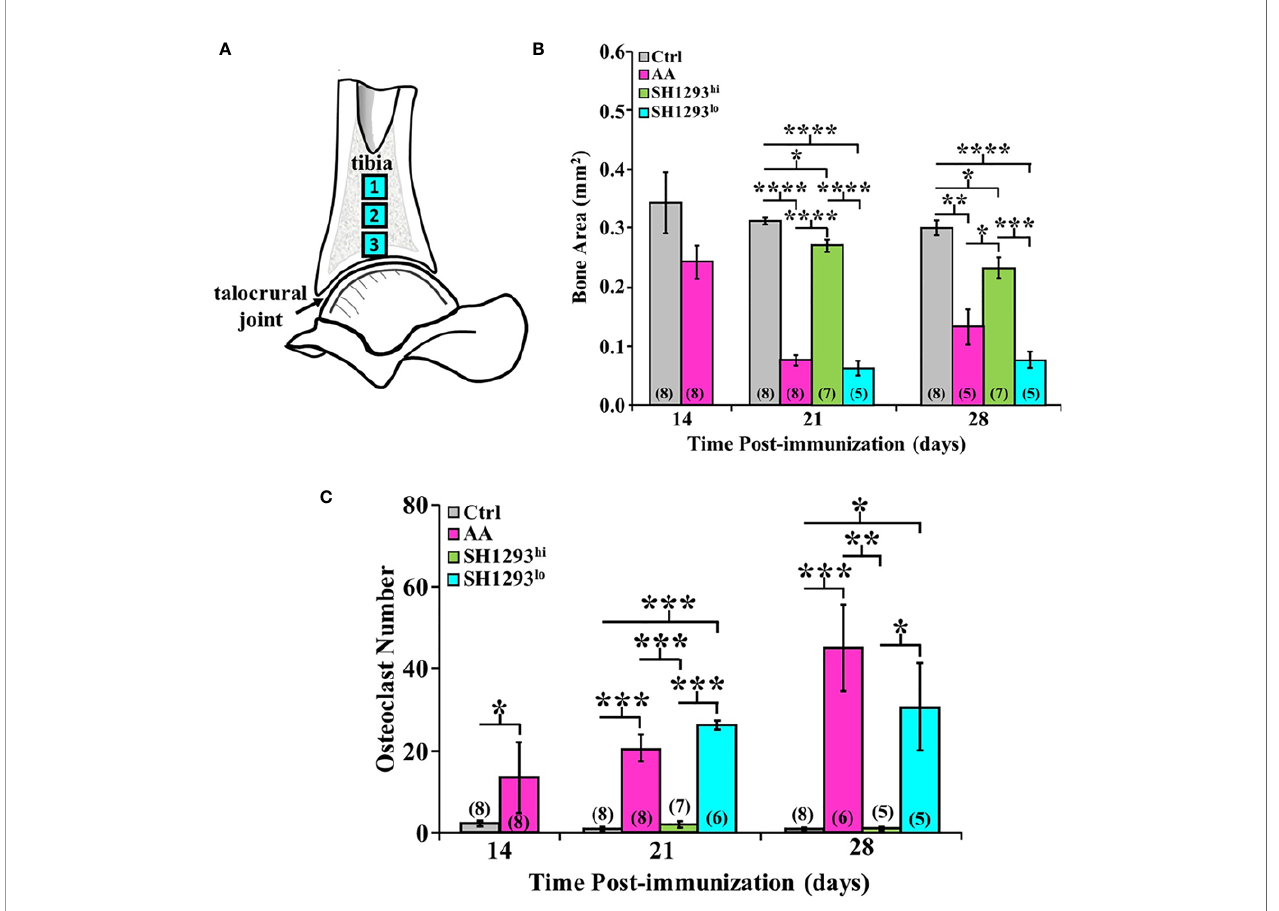
FIGURE 7 | High and Low Response of SH1293 on Bone Area and Osteoclast Numbers in the Distal Talus. (A) Schematic illustration of the sampling sites in distal tibia used to quantify mean bone area (in mm 2 ), and mean osteoclast number. (B) Bone area is plotted as a mean of a mean in mm 2 across time (in days) after immunization to induce IA. Bone area in AA rats did not differ from Ctrl rats at D14. Although signi fi cance levels between treatment groups differed at D21 and D28, the fi ndings at these time points were similar. At D21 and D28, bone area was signi fi cantly less in AA than Ctrl rats. In contrast, at D21 and D28, bone area was signi fi cantly greater in SH1293 hi -responder than in AA or SH1293 lo -responder rats. Still, bone area in SH1293hi rats was signi fi cantly less than in Ctrl rats. (C) Graph plotting the number of osteoclasts expressed as a mean of a mean in three sample sites in the distal tibia across time (in days) after immunization to induce IA. Despite the variability in AA rats, mean osteoclast number was greater in AA than Ctrl rats at D14. At D21 and D28, mean osteoclast number was low in Ctrl and SH1293 hi -responders compared with their number in the distal tibia of AA or SH1293 lo -responder rats. The numbers in parentheses at the bottom of each bar indicate the number of rats per group. Asterisks identify statistically signi fi cant differences as follows: * p < 0.05, ** p < 0.01, *** p < 0.001, **** p <